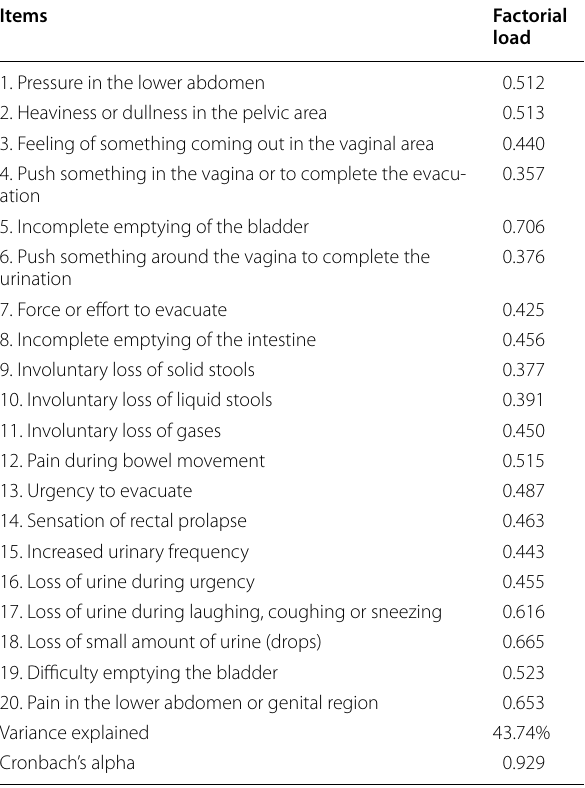
Table 2 Factor loads of the one-dimensional structure of the